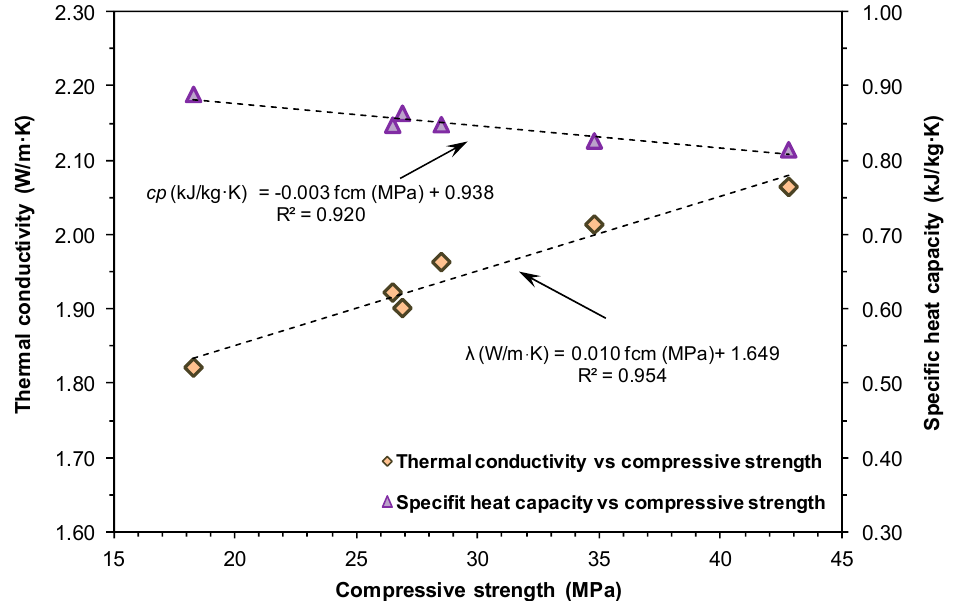
Figure 8. Compressive strength / thermal conductivity and compressive strength / specific heat capacity relationships for all concrete mixes.